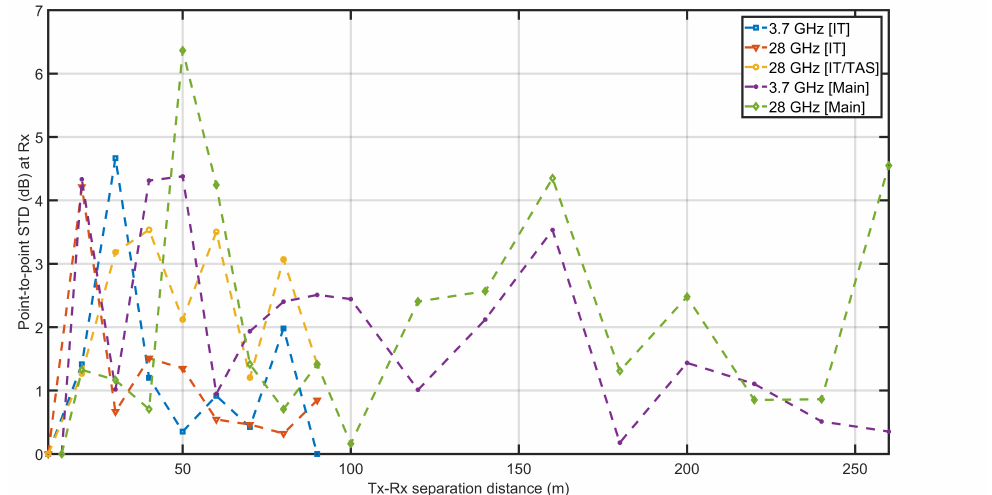
Figure 6. The figure depicts CI, CIF, FI, ABG, and the measured path loss in LOS link at the frequency of 3.7 GHz ( a , c ) and at 28 GHz ( b , d ).